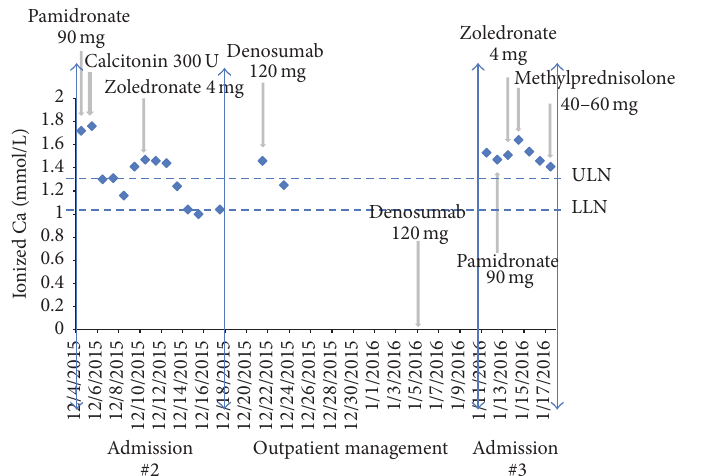
Figure 1: Evolution of hypercalcemia in relation to medical therapies instituted. Please note that majority of ionized calcium data from first admission are unavailable. Also, ionized calcium levels are unavailable on 1/5/2016 when denosumab was administered.